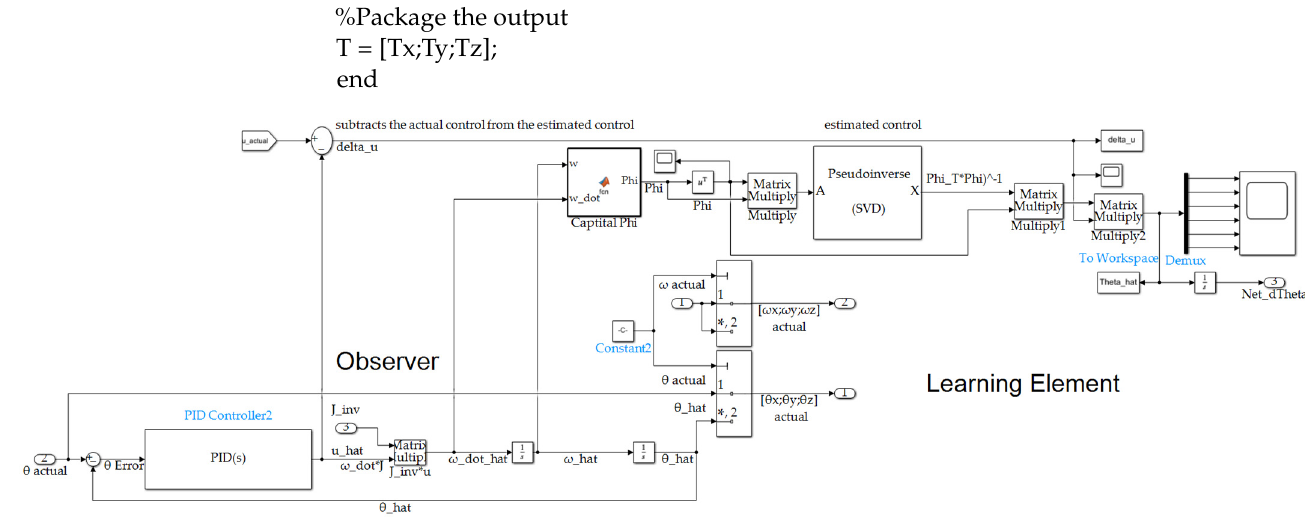
Figure A4. Observer subsystem depicted in Figure A3.